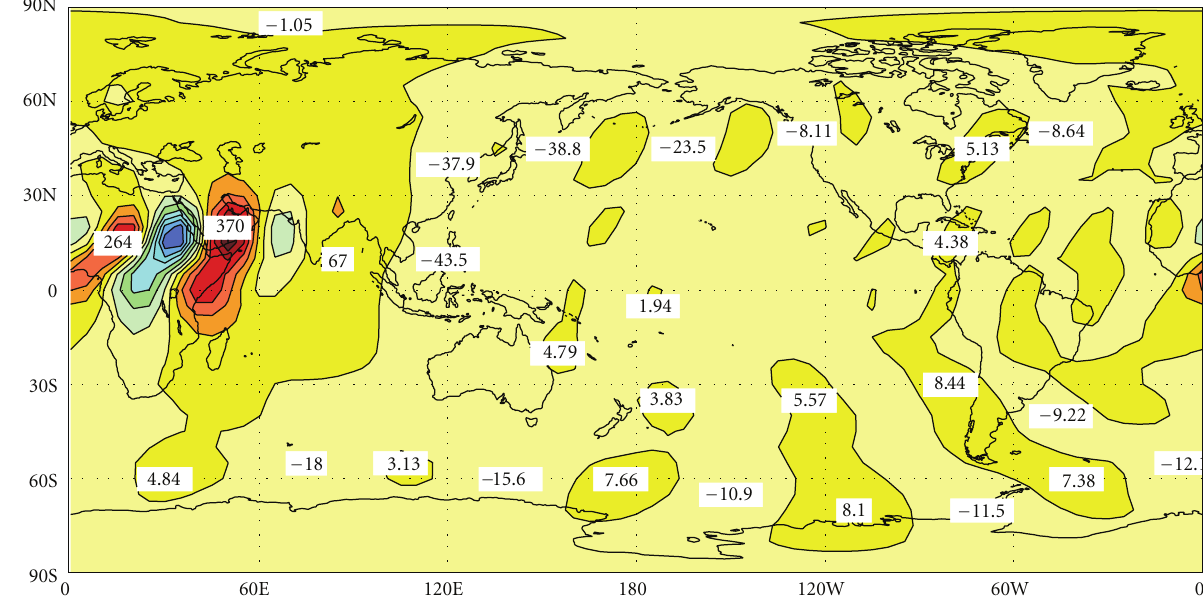
Figure 8: As in Figure 4(a) but for the African easterly wave, mode 7, for the July 1975–94 basic state. , growth rates ω d , and e-folding times τ d , of modes for the 1949–68 basic state with Q d Table 3: Periods T d i i r and for di ff erent K (cid:3) d , which have the largest pattern correlations A c with leading ML blocking, NWCB, and ISO modes for the 1949–68 basic state with standard parameterizations. Also shown are the mode